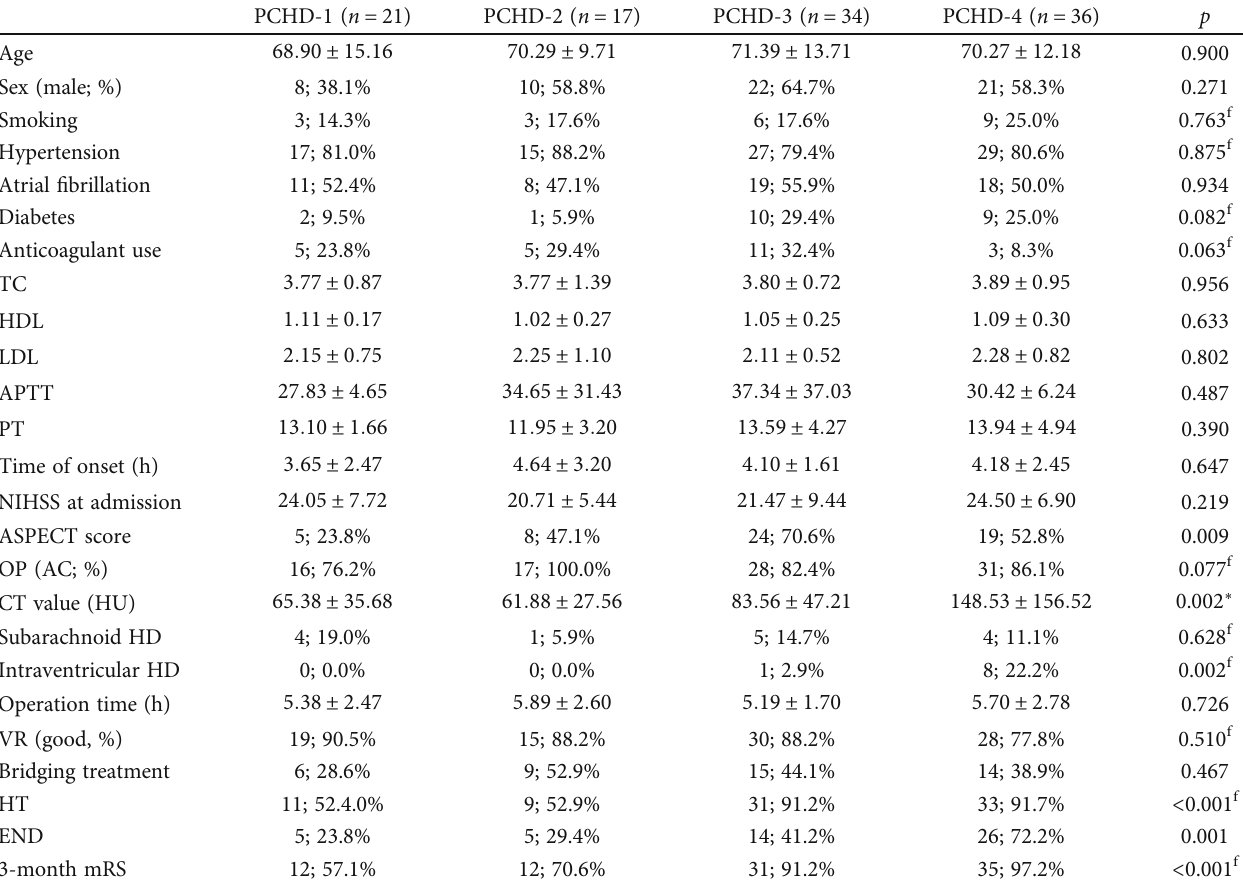
Table 2: Demographic and clinical characteristics of the four subtypes of